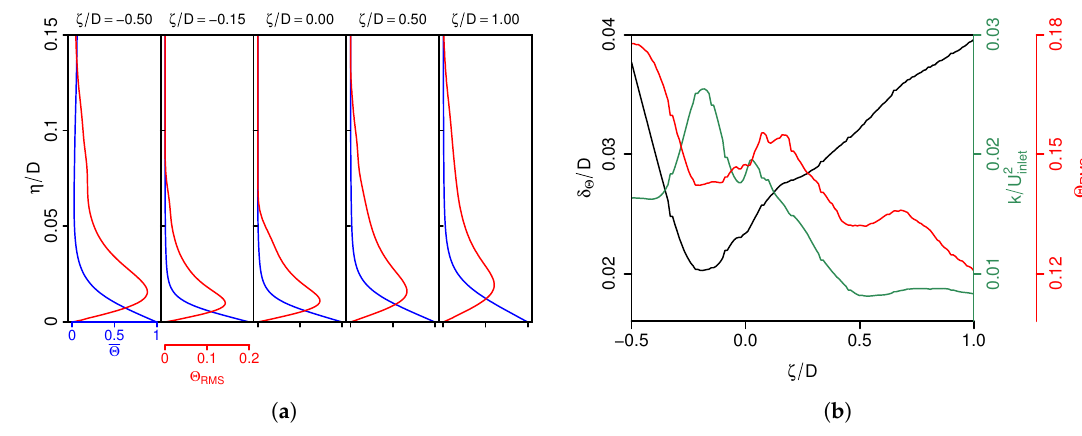
Figure 4. ( a ) The mean Θ ( ) and RMS temperature Θ RMS ( ) with respect to the non-dimensional wall distance; ( b ) thermal boundary layer thickness δ Θ ( ) and peak values of turbulent kinetic energy k ( ) and RMS temperature Θ RMS ( ) along the wall parallel direction ζ / D